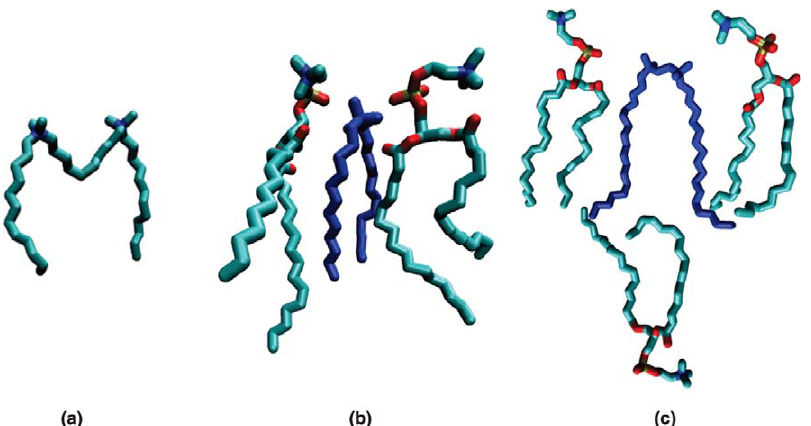
Figure 9. Snapshots selected from the MD simulations, illustrating (a) a typical conformation of the 12-10-12 molecule (the long hydrophobic spacer bending towards the interior of the bilayer), and the positioning of the (b) 12-2-12 and (c) 18-2-18 molecules relative to the neighboring phospholipid molecules. The larger conformational freedom found close to bilayer centre observed for the short tail surfactant contrasts with the interdigitation evidence observed for the long tail surfactant.